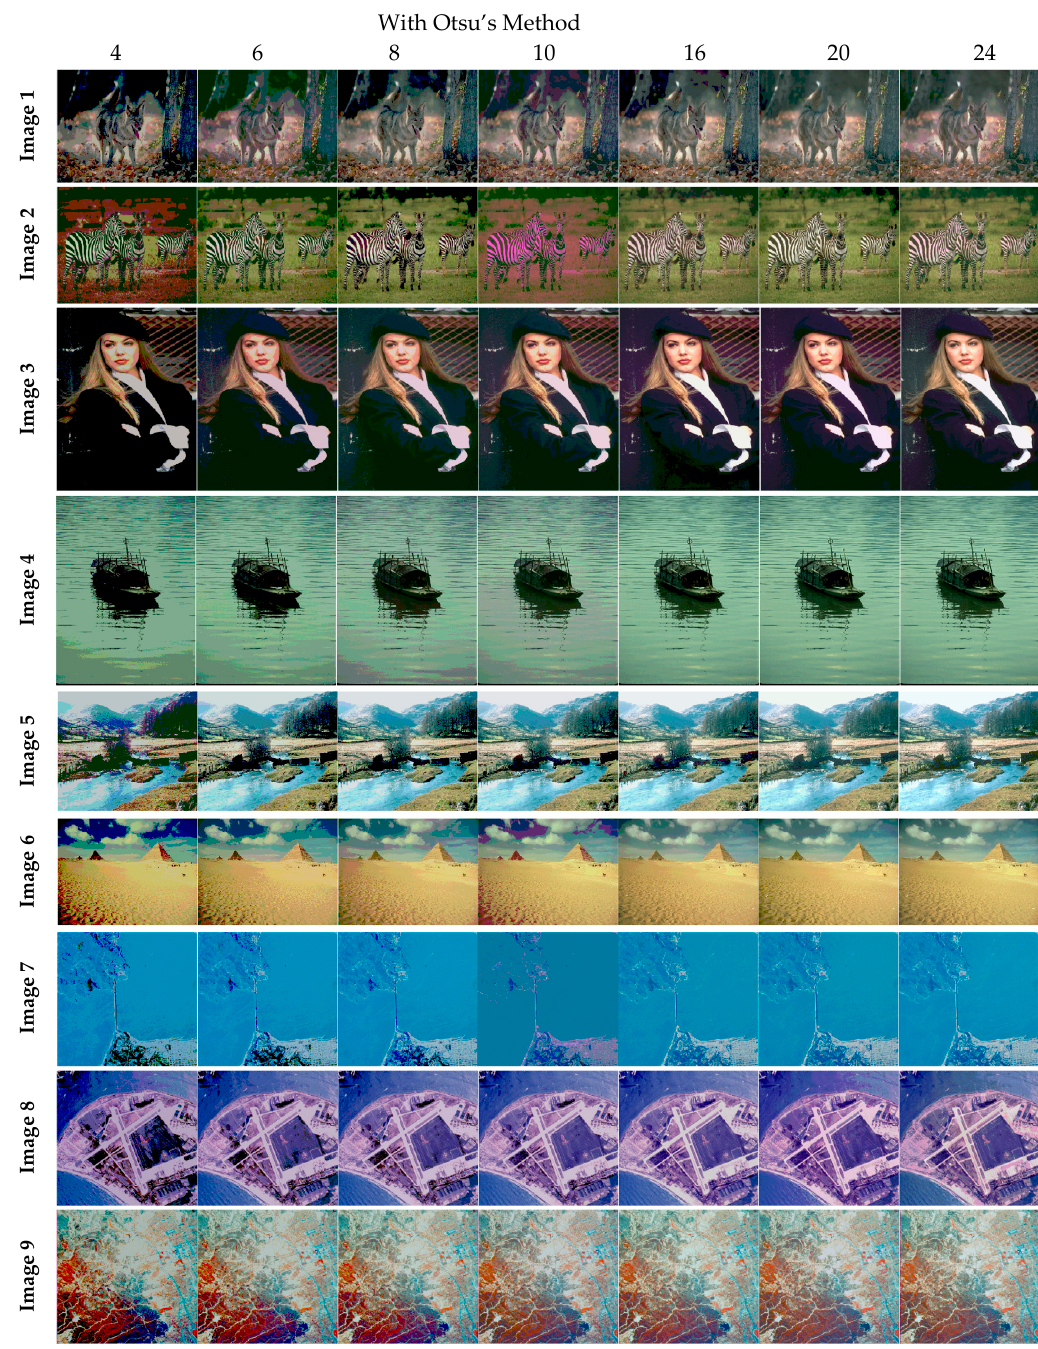
Figure 3. Segmented images of Image 1 to Image 9 for N = 4, 6, 8, 10, 16, 20, and 24 using the pro- posed method based on Otsu’s method.